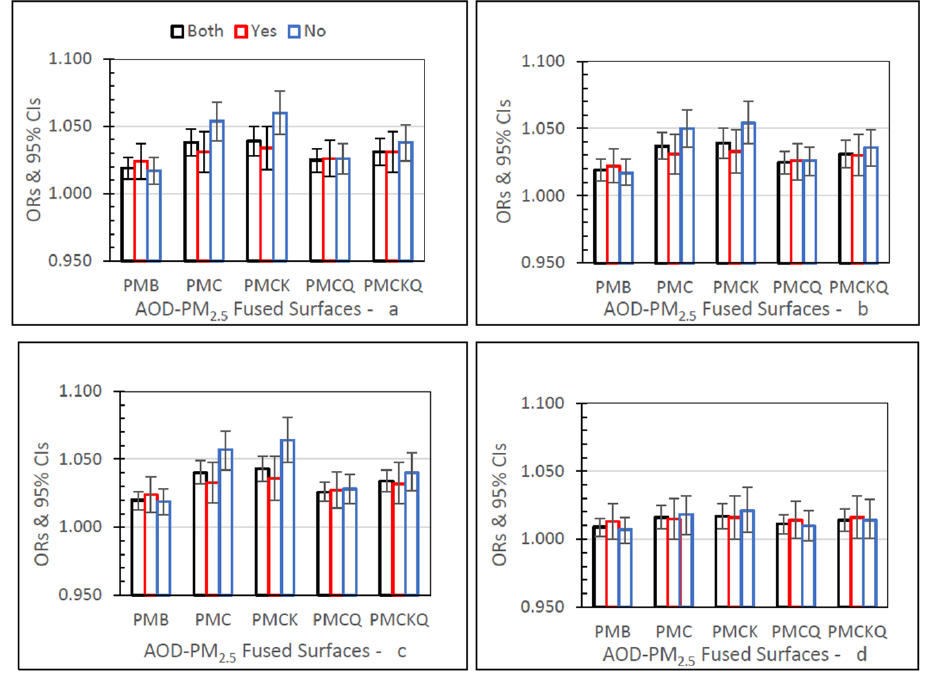
Figure 4. IP MI ORs (95% CIs) for the four AOD-PM 2.5 and baseline PMB fused surfaces, in all grids (Both), and in grids with (Yes) and without (No) air monitors, and in separate panels for lag grids 0 ( a ), 1 ( b ), 01 ( c ), and 04 ( d ).